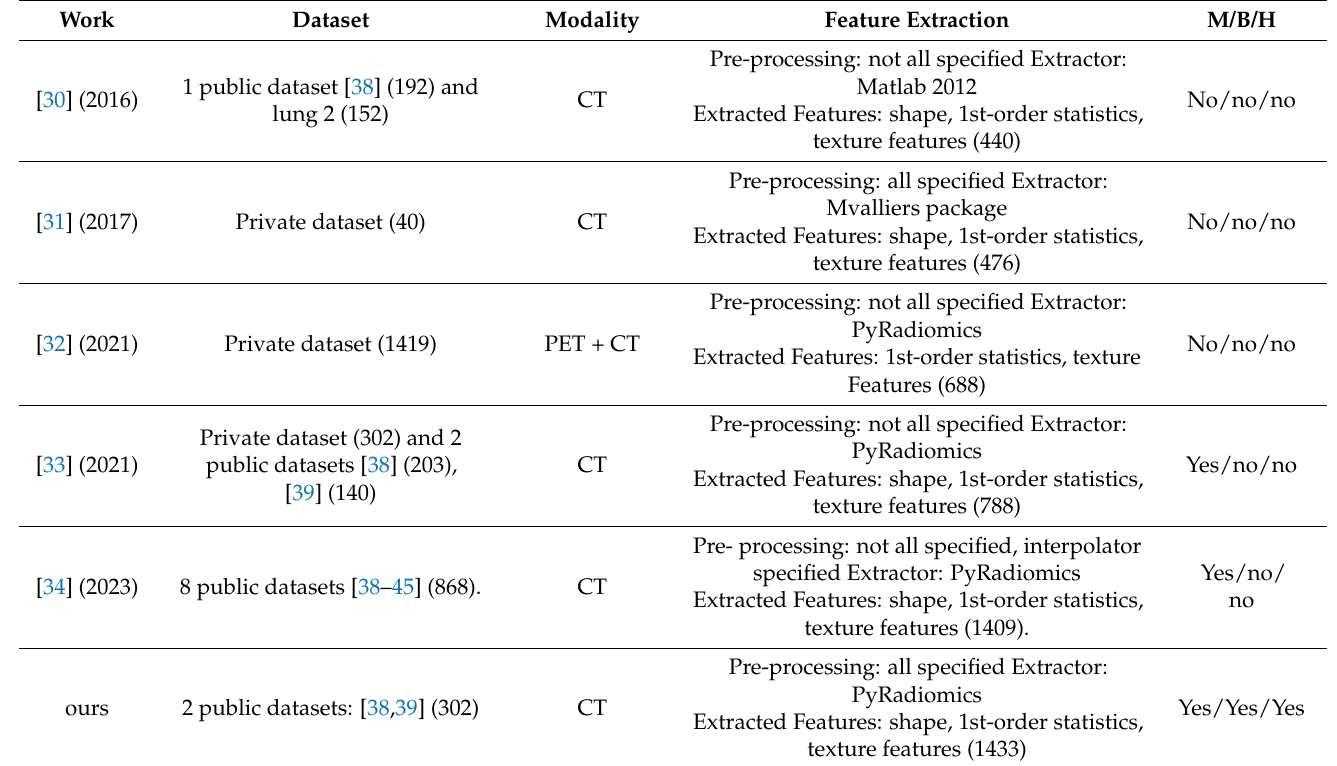
Table 1. The binary classification studies (SCC vs. ADC). M: multicenter, B: batch analysis, and H: harmonization. The number in the round brackets in the dataset column refers to the number of patients that were involved after a selection from the total available amount.